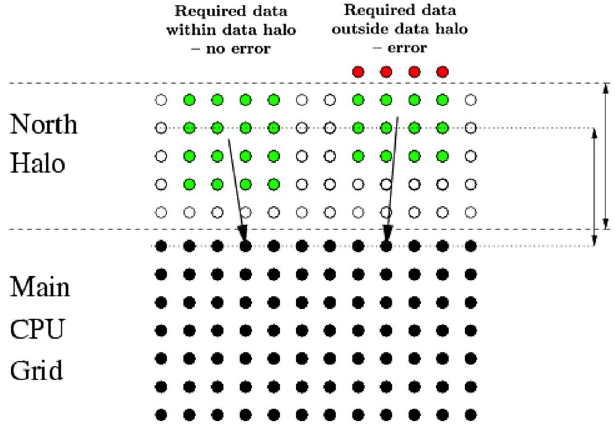
Fig. 2. Schematic illustrating the halo error. On the right hand side of the fi gure, the advection scheme can be seen trying to access data that is outside of the halo region which causes an error. The halo size can be increased to accommodate the larger winds present in the upper